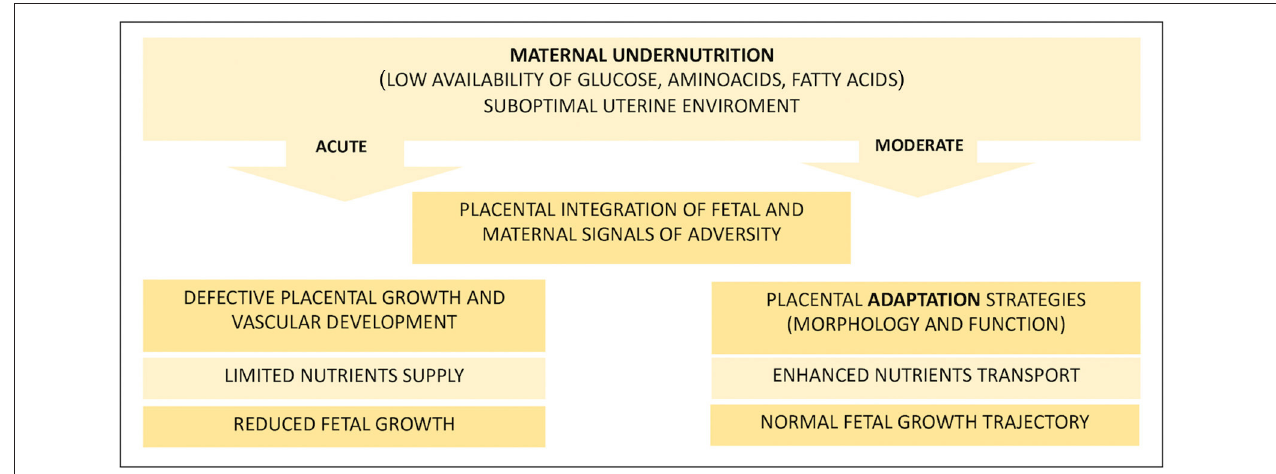
FIGURE 1 | Fetal and placental effects of maternal nutritional treatments. This diagram summarizes the main events that follow an acute or moderate dietary restriction faced by the pregnant mother that affects the uterine environment. Ruminants that receive reduced maternal nutrition in early pregnancy develop a suboptimal uterine environment, and the fate of pregnancy is highly dependent on the extent of the reduction and, in turn, on the adaptability of the placenta. Acute nutritional deprivation results in defective development of the placenta, which is unable to support fetal growth with an adequate amount of nutrients. Otherwise, if the reduction of nutrients is moderate, the placenta can adapt its development by improving the transport capacity of nutrients to meet growing fetal needs and ensure the maintenance of a normal growth